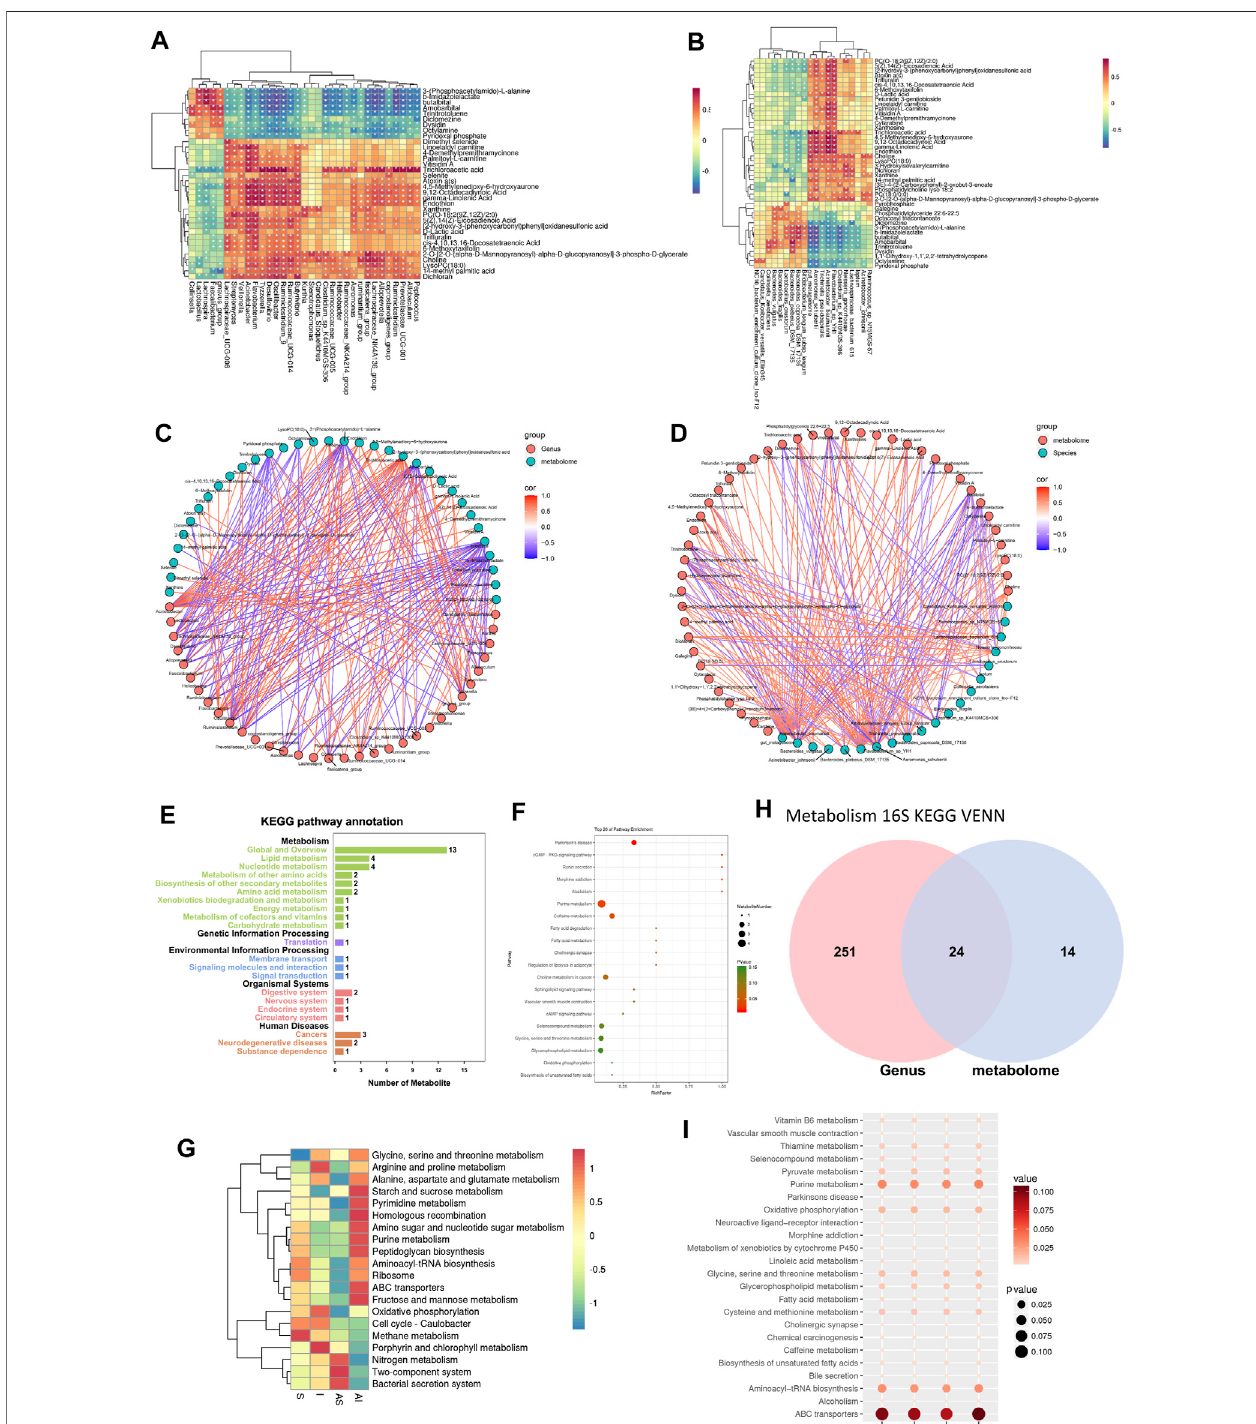
FIGURE 6 | The correlation between differential metabolites and lung microbiota. Correlation heat maps at both genus and species levels are mapped based on O2PLSanalysis (A,B) .Theconnectionsbetweenthelungmicrobiotaandmetabolitesatbothlevelsaremultiple (C,D) .KEGGpathwayannotationanalysisofmetabolism (E) . Bubble chart from the top 20 pathways enriching with the most metabolites (F) . The heat map of the top 20 most relevant pathways according to analysis of the microbial community (G) . Venn diagrams of 24 shared pathways (H) . Bubble chart from the 24 shared pathways (I) . S: sham; AS: ARB + sham; I: injury; AI: ARB + injury; KEGG: Kyoto Encyclopedia of Genes and Genomes; O2PLS: Two-way Orthogonal Partial Least Squares.